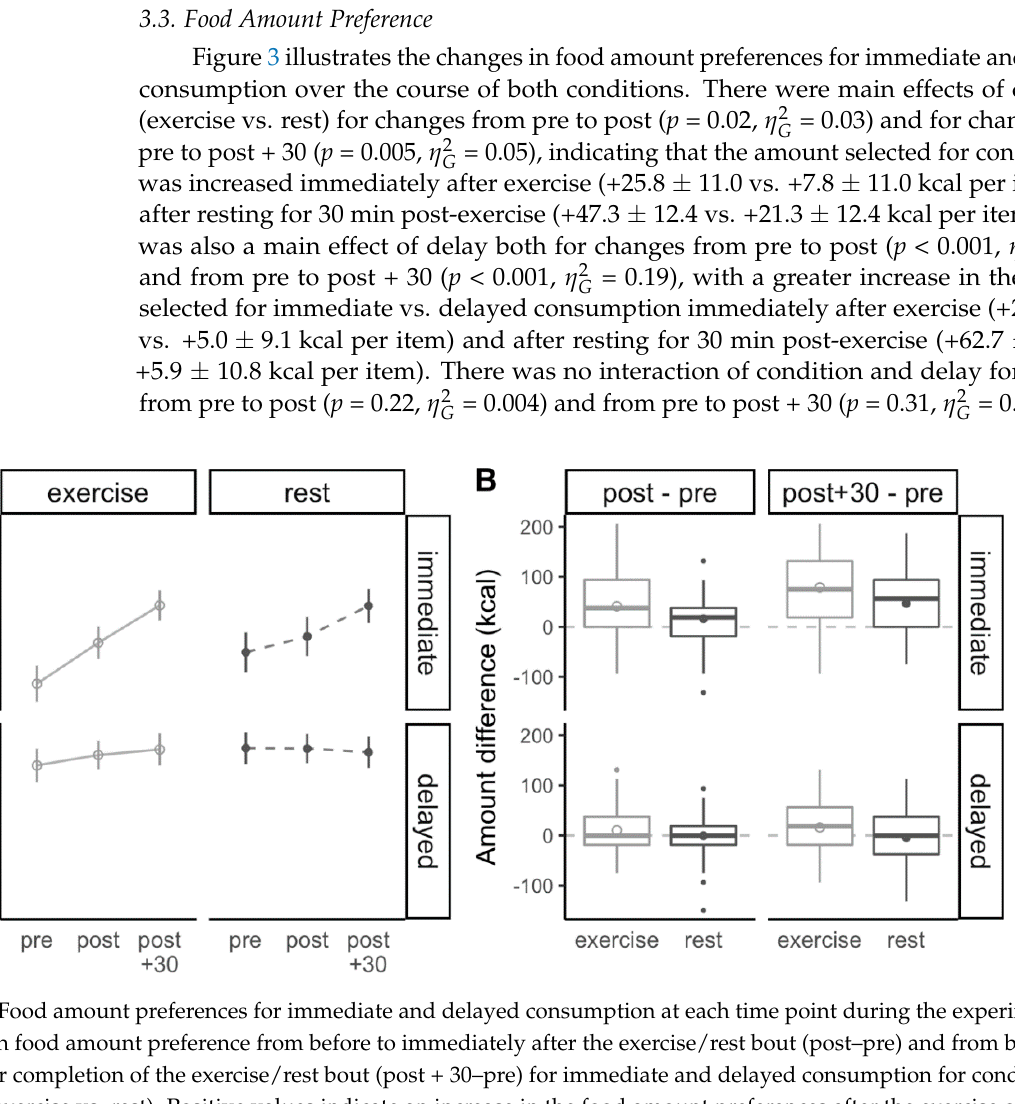
Figure 2. Subjective ratings of fullness, hunger, thirst, nausea, and stress at each time point (pre, post, post + 30) for both conditions. Circles represent means and error bars represent 95% within-subject confidence intervals.